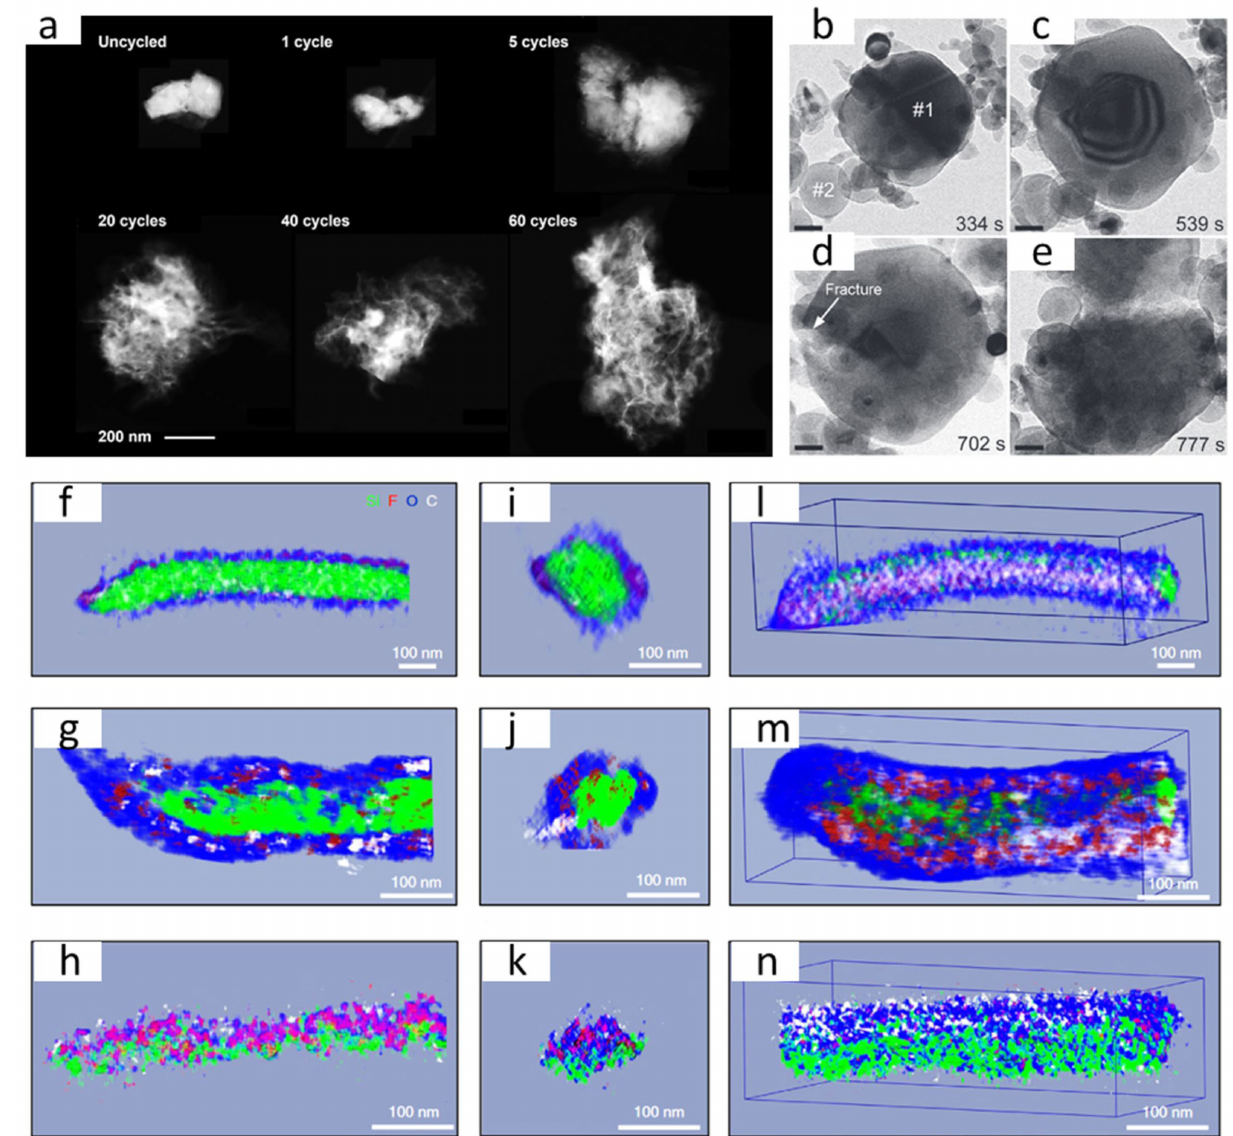
Figure 3. ( a ) Scanning transmission microscope image of silicon particles cycling with different number of cycles Reprinted with permission from Ref. [56]. 2018, Iopscience. ( b – e ) Time-series of images of the lithiation and fracture of a large ( ∼ 450 nm initial diameter) nanoparticle. The lithiated lithium source is to the left of the frame. ( b ) Lithiation has just started to occur, with the Li x Si phase visible around the edges of particle #1. Particle #2 has already become partially lithiated. ( c ) The crystalline Si core is clearly visible as the darker-contrast region in the center of particle #1. ( d ) Fracture initiates at the left surface of particle #1. ( e ) After fracture, the interior Si region of the particle is quickly lithiated and the crack grows, tearing the particle apart. Reprinted with permission from Ref. [20]. 2012, Wiley. ( f – n ) Segmented viewing of 3D cryo-STEM-EDS chemical composition from two directions, Segmented view parallel to the wire axis after the 1st cycle ( f ), 36th cycle ( g ), and 100th cycle ( h ). Slice thickness is 5nm. Segmented cross-section view for the 1st ( i ), 36th ( j ), and 100th ( k ) cycles. The 3D view for the 1st ( l ), 36th ( m ), and 100th ( n ) cycles. Reprinted with permission from Ref. [57]. 2018,